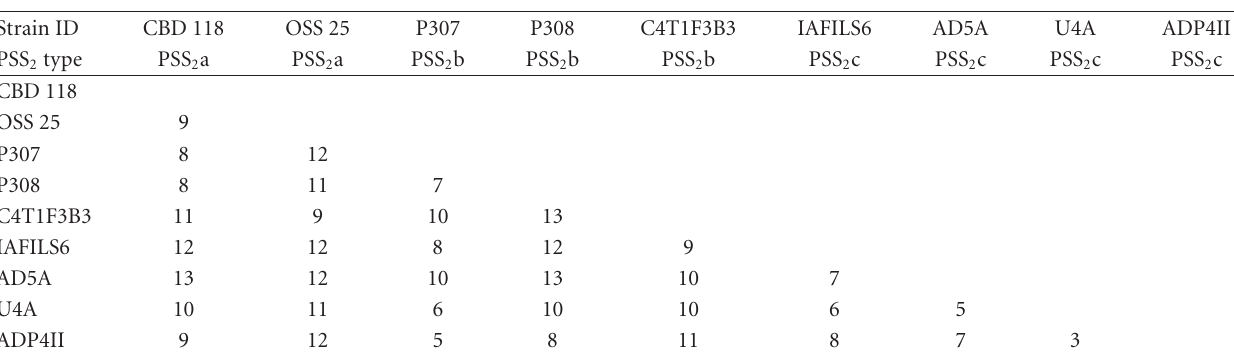
Table 5: Number of di ff erential phenotypic traits between paired Bacillus strains among 100 traits tested with reference to the presumptive signature sequence 2 type (PSS 2